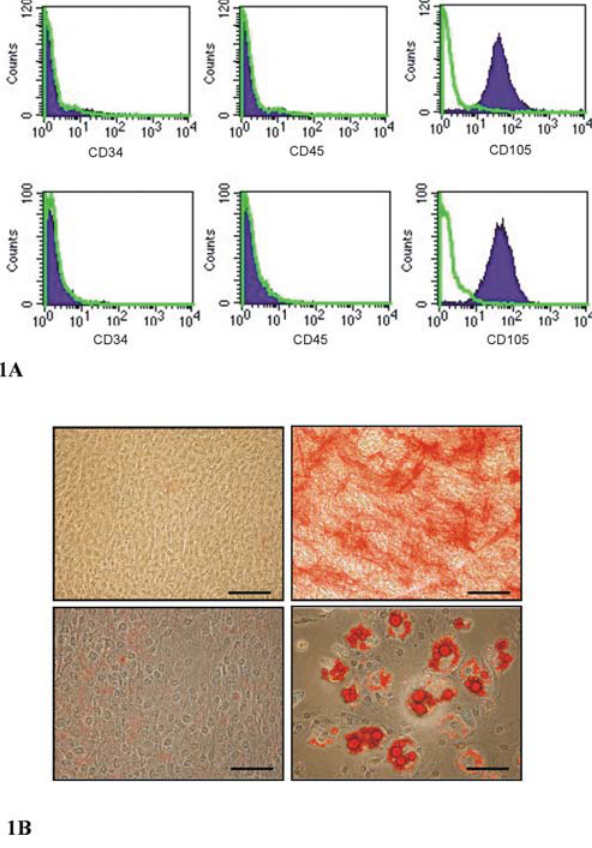
Figure 1. Characterisation of primary MSCs by flow cytometry and differentiation assays. A. Flow cytometry analysis of all primary murineMSC cultures(upper panel)and humanMSC (lowerpanel) cultures showed they were CD34 and CD45 negative, and CD105 positive. CD molecule antibody staining is represented by the filled histogram; isotype control staining is represented by the green line. B . Murine MSCs (CD45 2 , CD34 2 , CD105 + ) incubated in osteogenic medium for 21 days stained positive for alkaline phosphatase activity (top right), whereas murine MSCs incubated in culture medium alone did not stain positive (top left). Murine MSCs incubated in adipogenic medium for 21 days showed fat droplets in the cellsstained withOil Red O (bottom right),whereasmurine MSCs incubated in culture medium alone showed no positive staining (bottom left). The black bar represents 200 m m in the top panels and 100 m m in the bottom two panels.